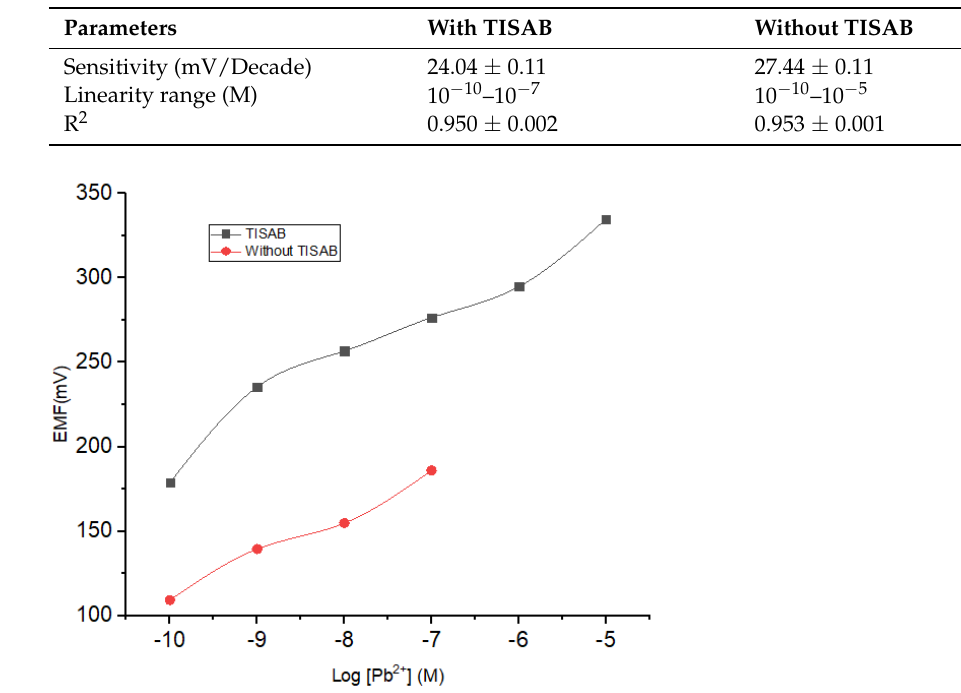
Table 3. TISAB solution comparison profile and without TISAB.